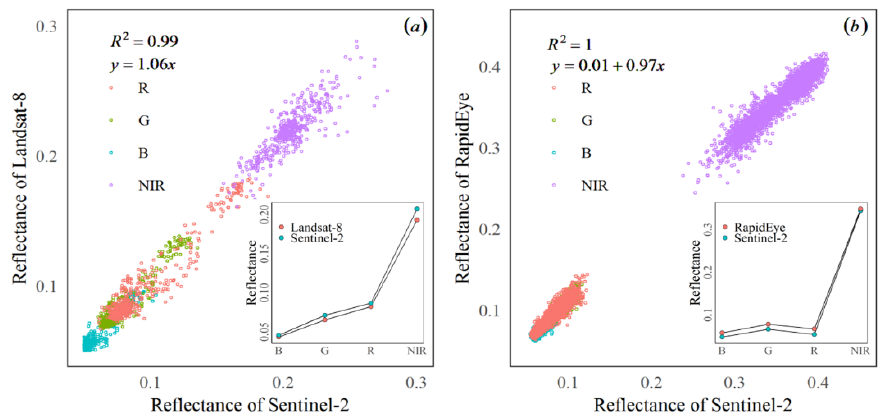
Figure 4. Comparison of spectral reflectance between Sentinel-2 and Landsat-8 ( a ) and between Sentinel-2 and RapidEye ( b ). R, G, B, and NIR represent red, green, blue, and near infrared bands, respectively. Table 4. Correlation between VI and grain protein content (GPC) (n = 109).